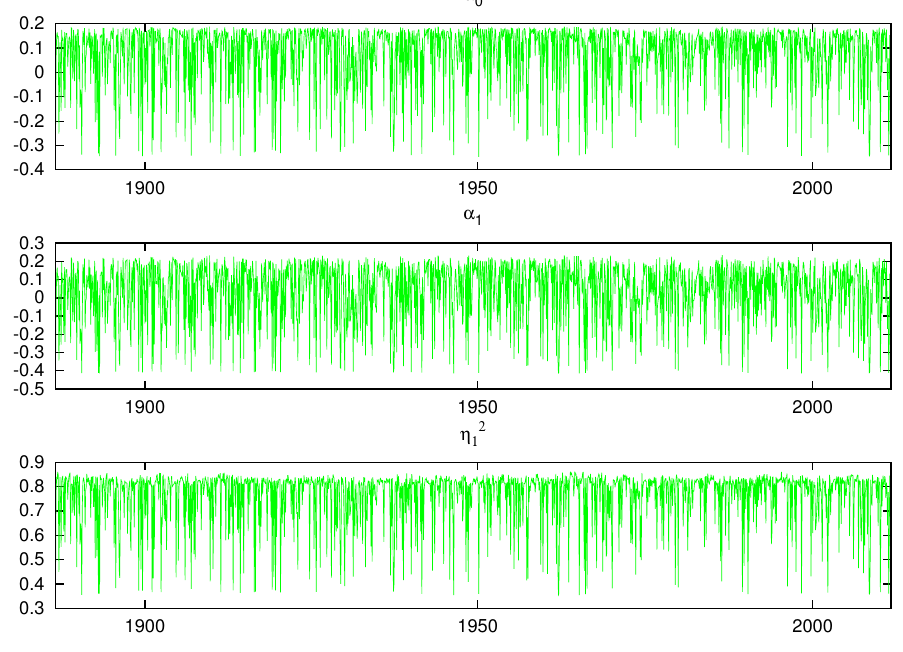
Figure 17. Posterior means of α 0, s